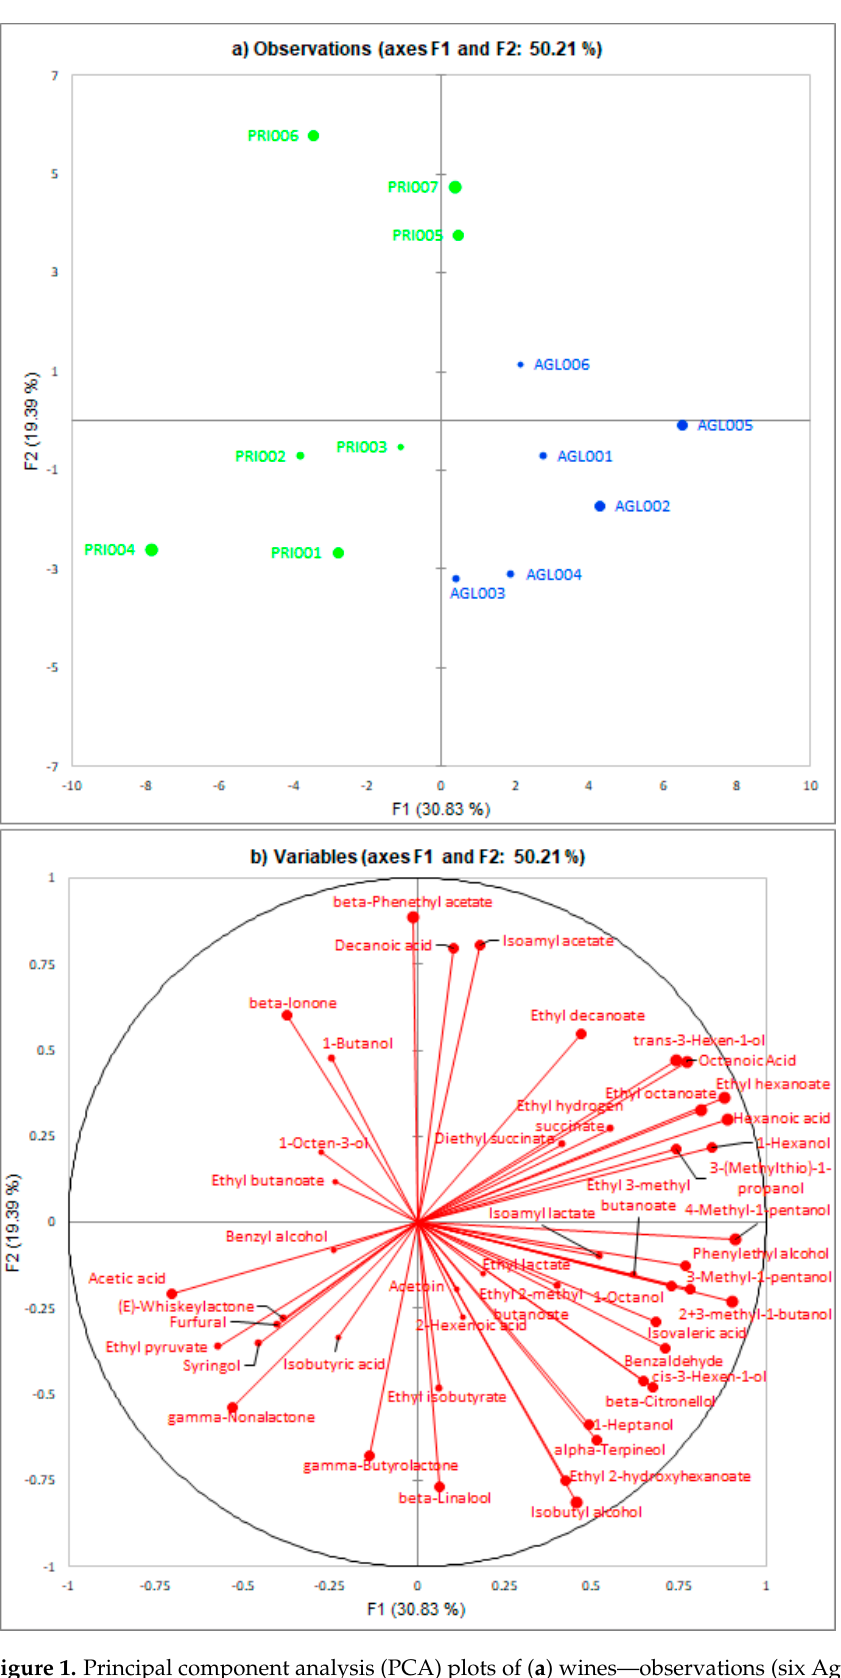
Figure 1. Principal component analysis (PCA) plots of ( a ) wines—observations (six Aglianico: AGL; seven Primitivo: PRI) and ( b ) volatile compounds—variables.